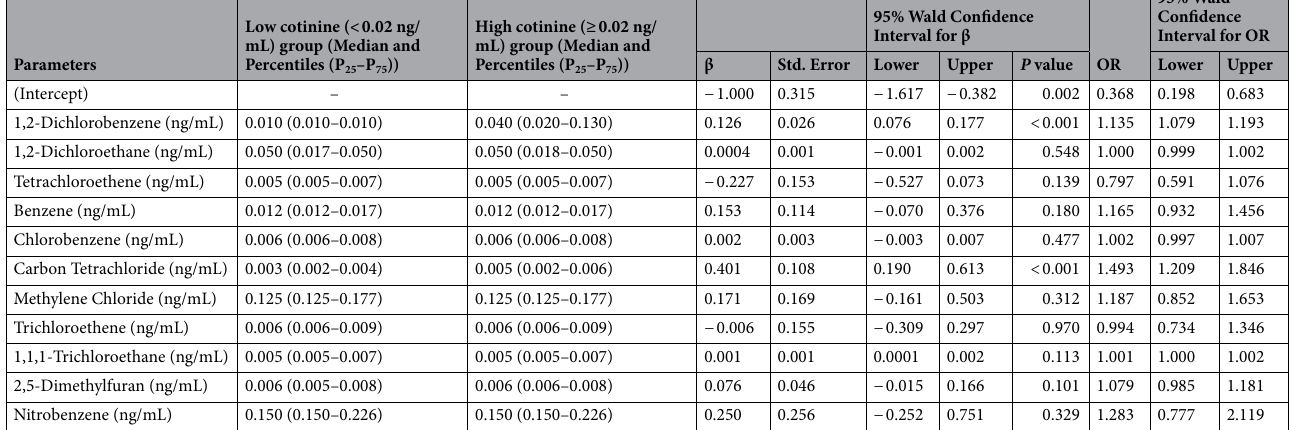
Table 2. Association between serum VOCs and cotinine levels in 10,538 non-smokers † . † Multivariable logistic regression analysis adjusted for age, gender, race/ethnicity, education, family poverty index ratio (PIR), depression status, and drug use history. Std. Error, standard error; OR, odds ratio; N, sample